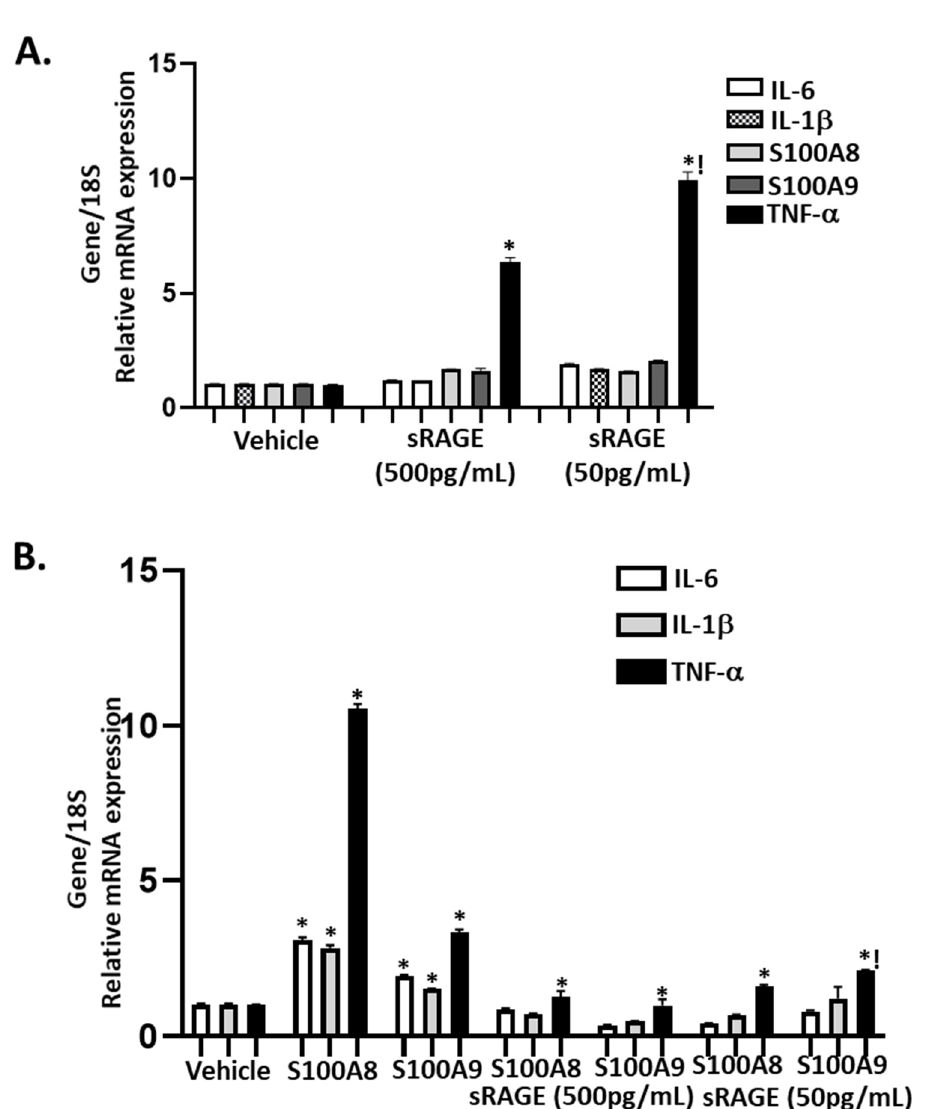
Figure 5. Pretreatment with sRAGEs alone or in combination with S100A8/A9 differentially regulate the expression of IL-6, IL-1 β , TNF- α , and S100A8/A9. Cultured aortic vascular smooth muscle cells were pretreated (1 h) with sRAGEs (50–500 pg/mL) or vehicle (PBS) ( A ) or in combination with S100A8 or s100A9 (0.05–0.5 g/mL) ( B ). Bars are mean+SEM of gene mRNA expression. * p < 0.05 vs. respective vehicle; ! p < 0.05 vs. sRAGEs (500 pg/mL). n = 3 different cultures.